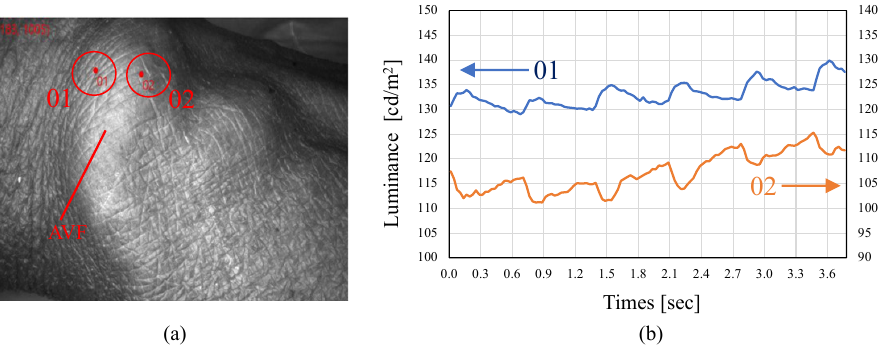
Figure 16. Measurement example of reversed-phase AVF pulse wave. ( a ) Photograph of measurement points on AVF. ( b ) Measured waveforms obtained at the two measurement